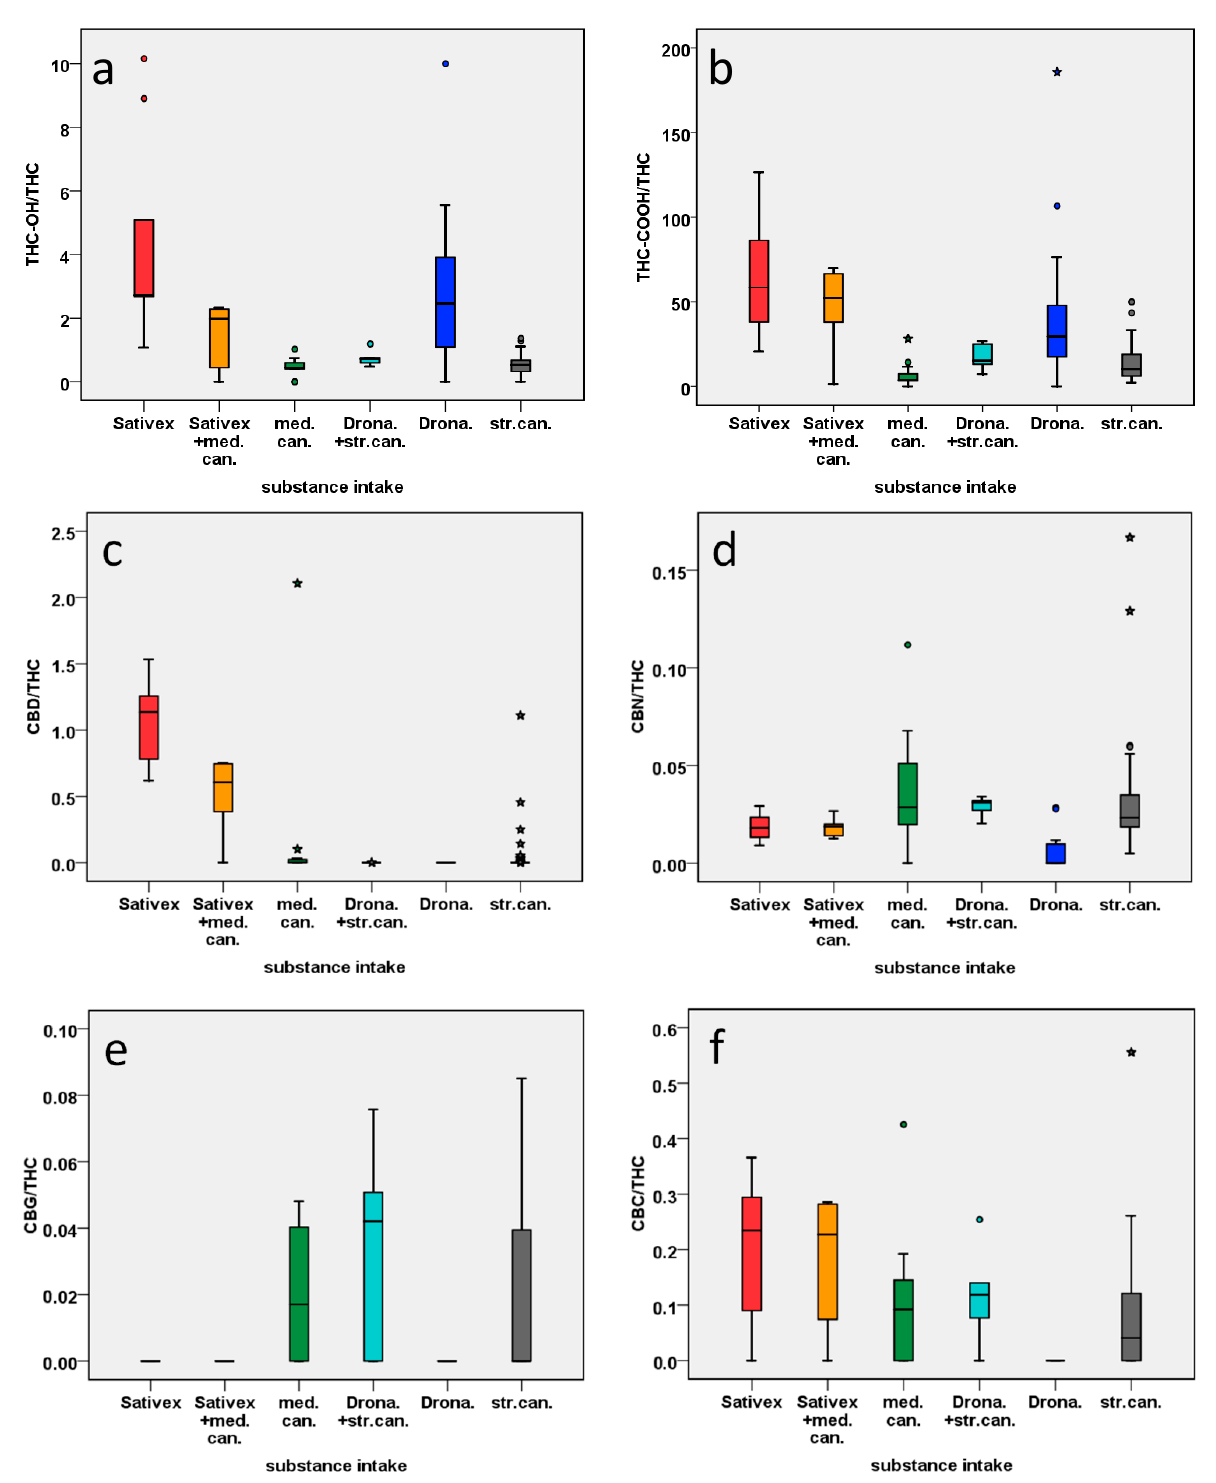
Figure 1. Boxplots of selected cannabinoids illustrate differences among subgroups. In Sativex ® user samples, standardized THC-OH ( a ), THC-COOH ( b ) and CBD ( c ) concentrations were higher than for medical cannabis (med.can.) or street cannabis (str.can) users. Dronabinol (Drona.) users also exhibited higher THC-OH and THC-COOH levels but fewer CBN ( d ) and CBC ( f ) than cannabis users. Cannabis user samples exhibited notably higher levels of CBG ( e ), compared to Sativex ® or Dronabinol users. * = Extreme outliers with values ≥ 3, * Interquartile Range (First Quartile–third Quartile).